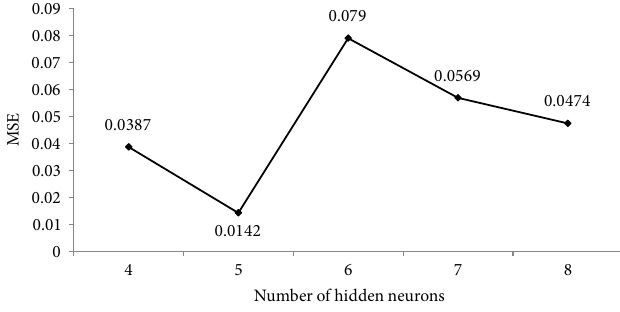
Figure 1. MSE versus the number of hidden neurons